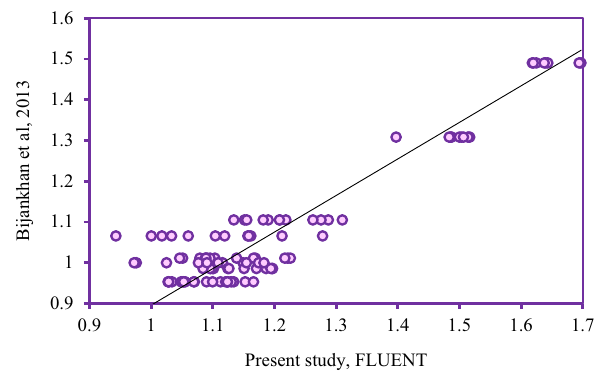
Fig. 17 Scatter plot of discharge coefficients obtained from of Fluent and Eq. (25)